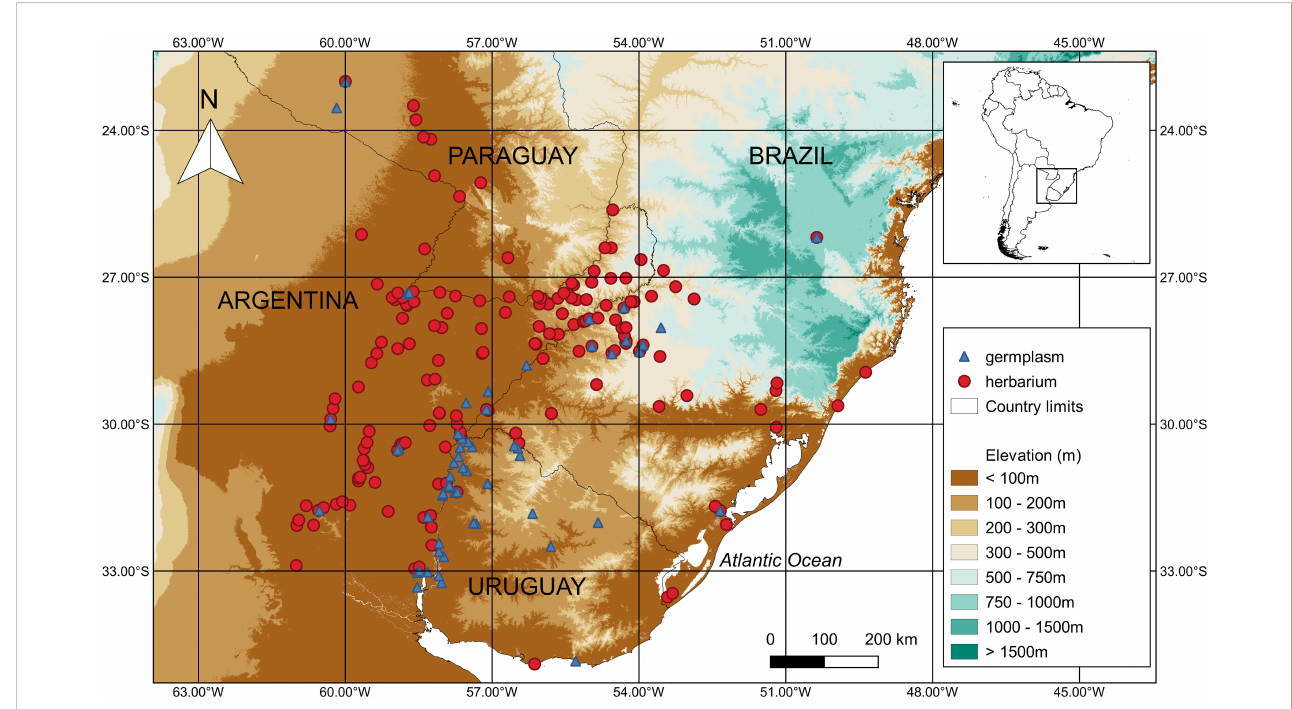
FIGURE 1 Geographical distribution of Solanum malmeanum (Solanaceae) in Southern South America. Occurrence points are represented by red circles for herbarium specimens and blue triangles for accessions in genebanks.